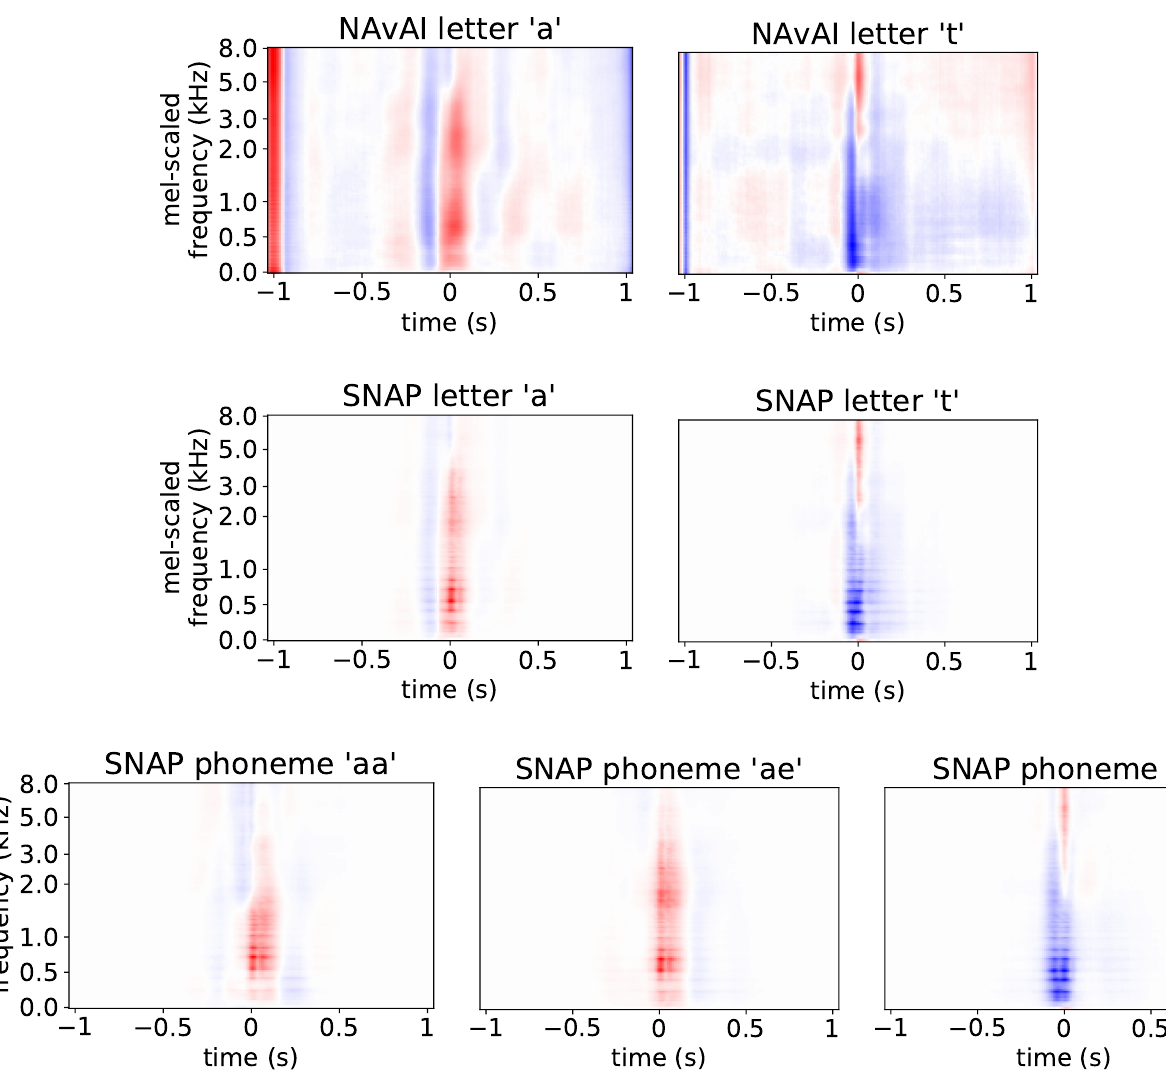
Figure 4. Comparison of NAvAI patterns with input layer SNAPs in model W2L for letters and phonemes. The plots visualize the difference of intensity of frequencies between group-average and the average over the complete data set. White indicates zero difference, red and blue color indicate higher and lower intensity, respectively. Lighter color also indicates small importance for the prediction. Colors represent the same values only for subfigures in the same